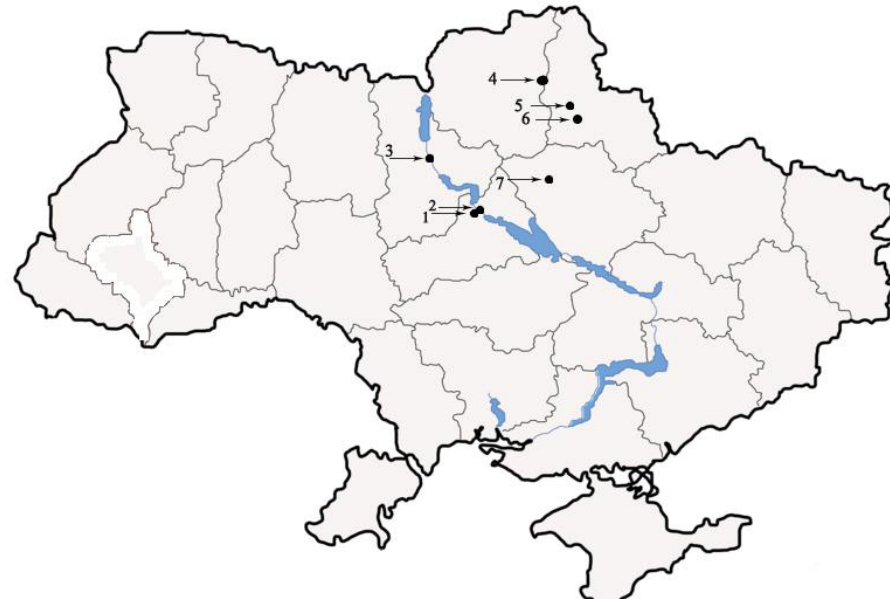
Fig. 3. Distribution of C. ucrainica localities in the territory of Ukraine according to the results of own research: 1 ‒ in the delta of the River Ros (Cherkasy region); 2 ‒ on the island of Shelestiv in the floodplain of the Dnieper (Kaniv Nature Reserve, Cherkasy region); 3 ‒ on the pine terrace (on the interfluve of the Desna and the Dnieper, Kyiv); 4 ‒ in Mezyn National Nature Park (Chernihiv region); 5 ‒ in a valley system near the town of Krolevecz (Desna river basin, Sumy region); 6 ‒ in the floodplain of the River Sejm (Sejm Regional Landscape Park, Sumy Region); 7 ‒ in the floodplain of the River Sula (Poltava region, locus classicus) Table 1. Characteristics of all known populations of C. ucrainica in Ukraine according to the results of our own research